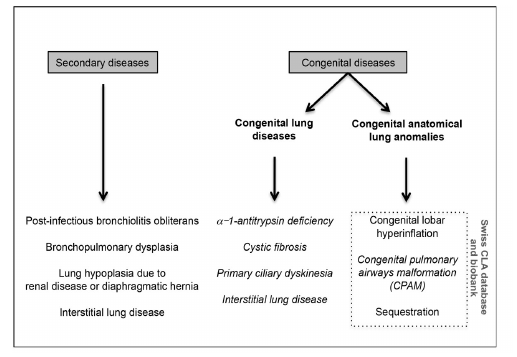
Figure 1: Schematic classification of paediatric chronic lung diseases. Italic text represents diseases where genetic mutations have been reported, sometimes only for a subgroup of these lung